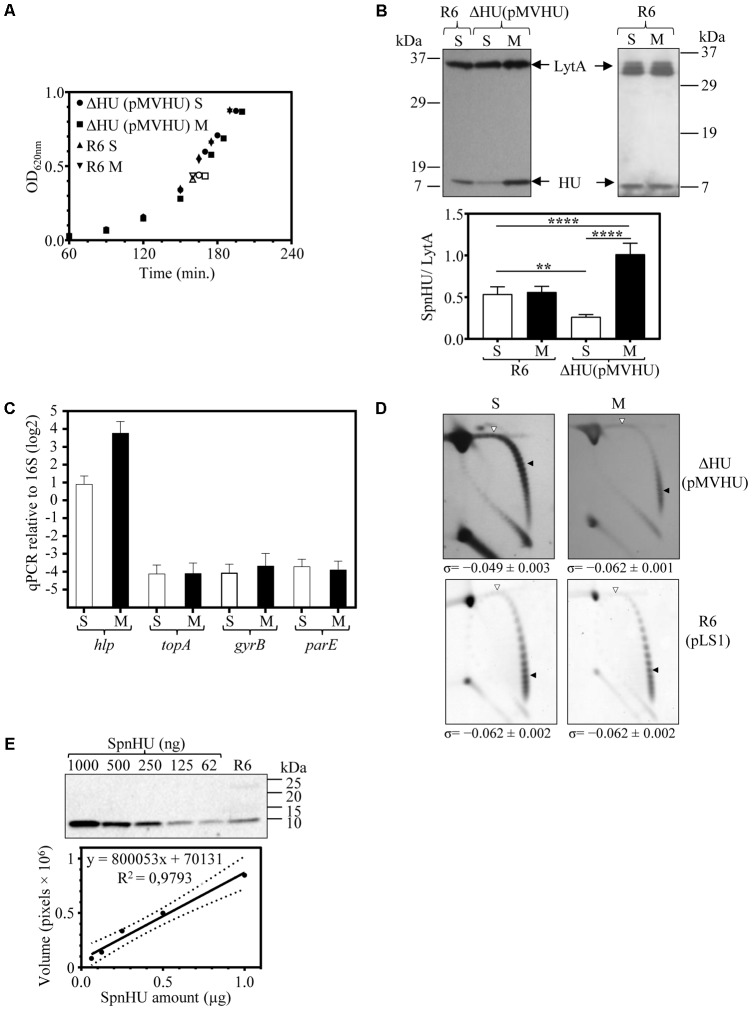
Oscillations in the amount of SpnHU affect the level of DNA supercoiling. Cultures of R6, R6 (pLS1), and ΔHU (pMVHU) were grown in medium containing sucrose. When the cultures reached OD620
nm= 0.2, they were diluted 50-fold in medium containing either sucrose (S) or maltose (M). Samples were obtained when the cultures reached OD620
nm= 0.4. (A) Growth kinetics of ΔHU (pMVHU) and R6 strains grown in sucrose and maltose-supplemented media. Open points indicate the time at which samples were collected. (B) Western blot analysis of SpnHU levels in samples grown in medium containing sucrose (S) or maltose (M). Crude cell extracts (20 μg) were separated by SDS-PAGE and blotted. To quantify SpnHU, values were divided by the amount of LytA protein as a loading control. Values are the average ± SD of three independent replicates. (∗P < 0.0332, ∗∗∗P < 0.0002). (C) qRT-PCR values of hlp, topA, gyrB, and parE genes in cells of ΔHU (pMVHU) grown in medium containing maltose or sucrose. Values of represented amplicons were calculated relative to those of 16S rDNA. Represented values are the average ± SD of three independent replicates. (D) Plasmid DNAs were isolated and subjected to 2D agarose gel electrophoresis as described in Section “Materials and Methods.” Supercoiling density (σ) values are averages ± SD from three independent replicates. (E) Western blot analysis of different amounts of purified SpnHU and a crude cell extract of R6 strain to calculate the number of SpnHU molecules per cell. The linearity of the SpnHU amount and volume expressed is presented as the number of pixels.